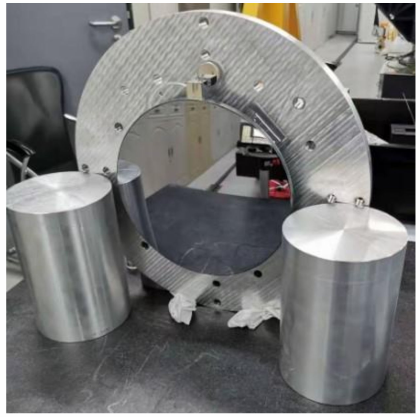
Figure 13. Stability